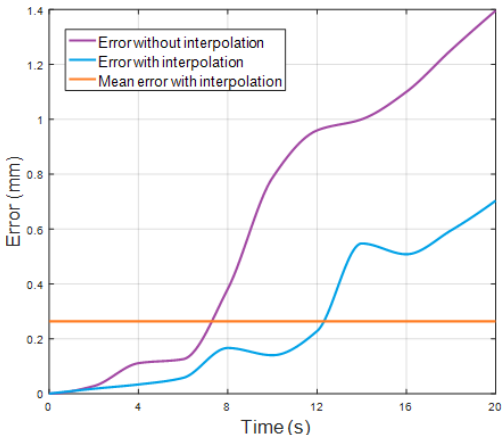
Figure 14. The position changes of the terminal point K 8 .